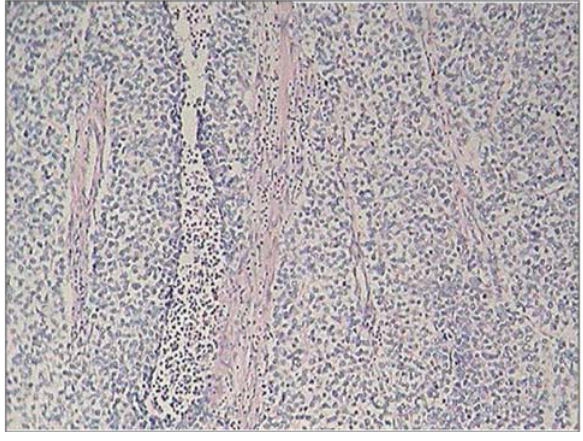
Figure 3. Dysgerminoma cells with prominent nucleoli arranged in lobules separated by thin fi brous septae in fi ltrated with lymphocytes. (H&E X20)